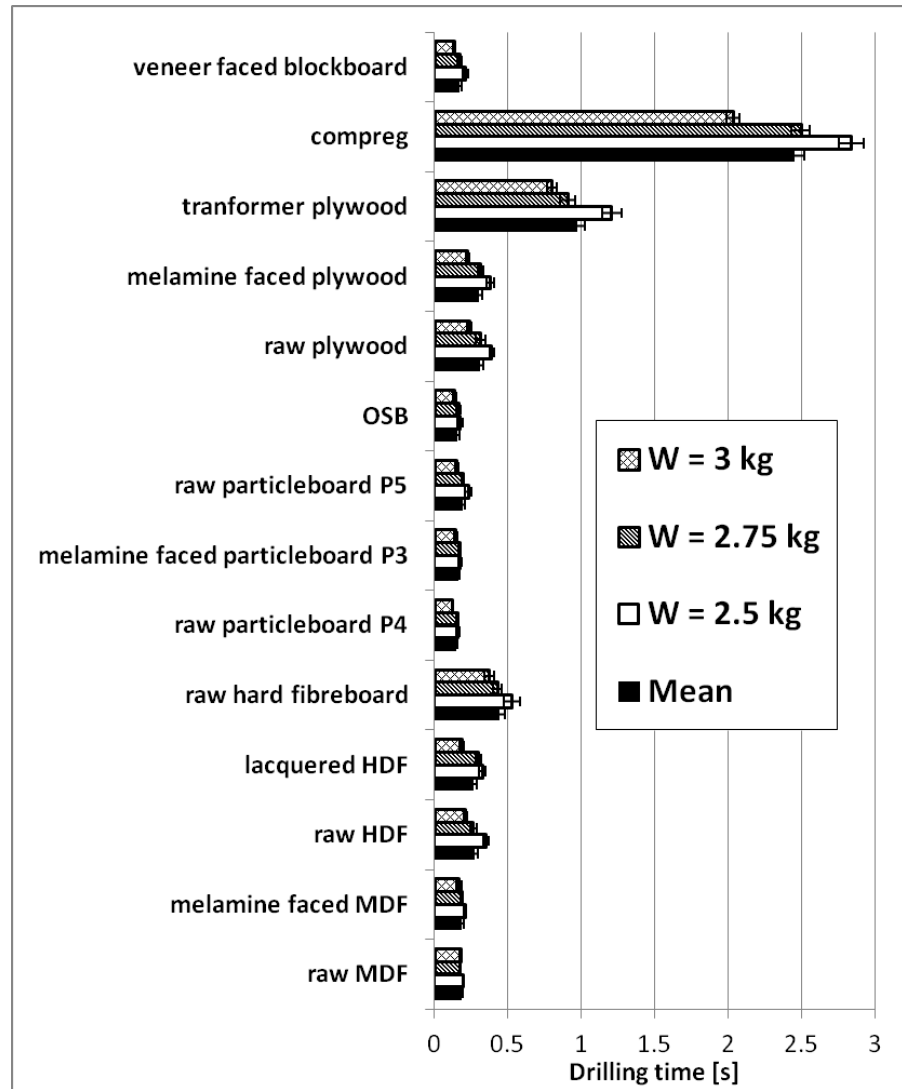
6 Figure 6. Differentiation of wood-based boards in terms of the time needed to make a 10 mm deep hole (drilling time) for three different weights (W).